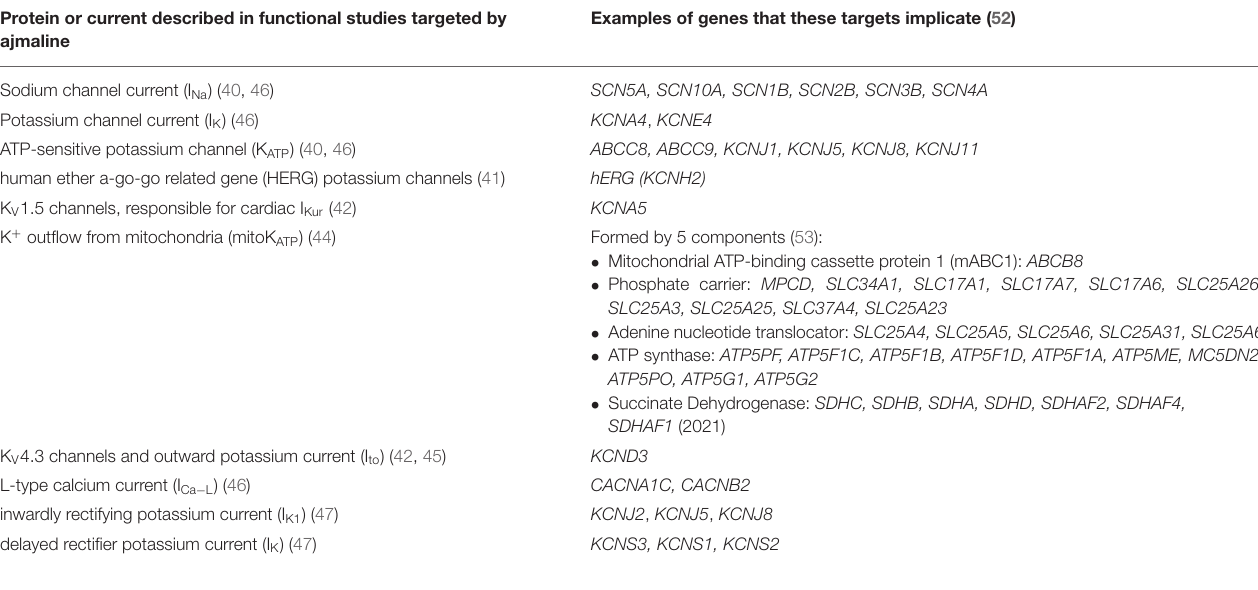
Examples of genes that these targets implicate (52)